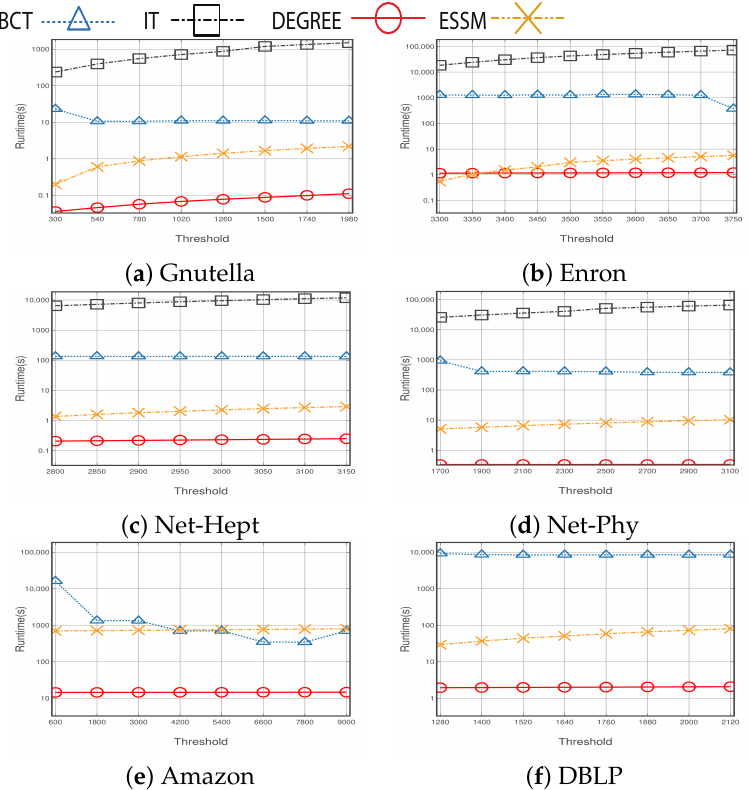
Figure 2. Comparison of Running time between ESSM and other algorithms with threshold T i from 300 to